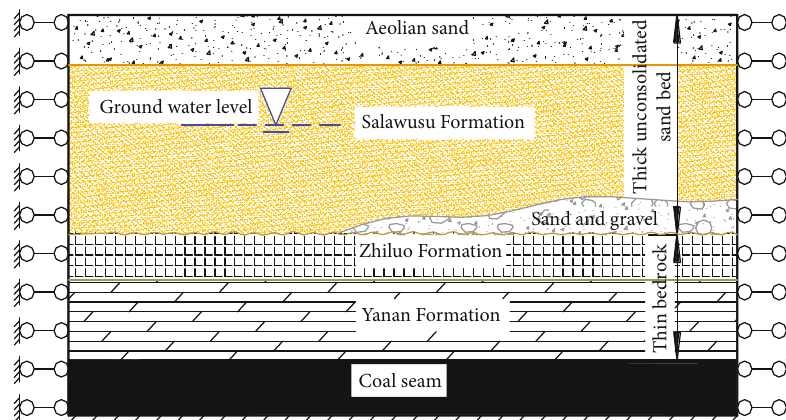
Figure 6: Combination of coal bearing